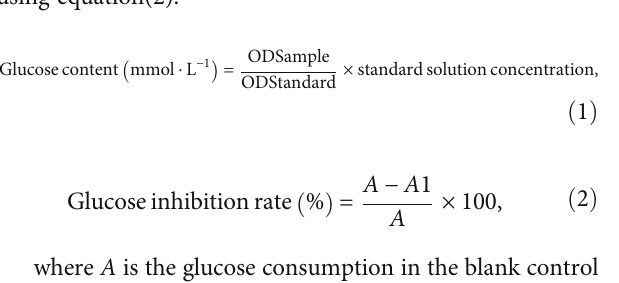
Table 1: Monosaccharide compositions in fresh rice